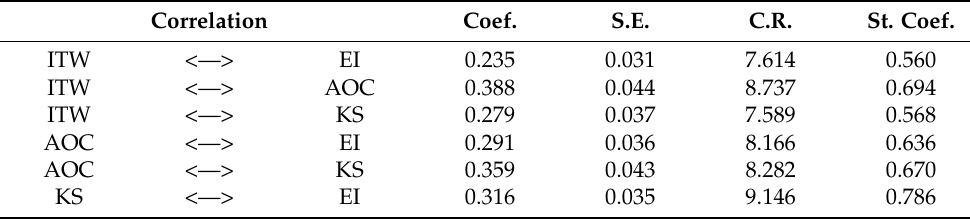
Table 3. Correlations among the latent variables in the revised CFA model. Correlation Coef.